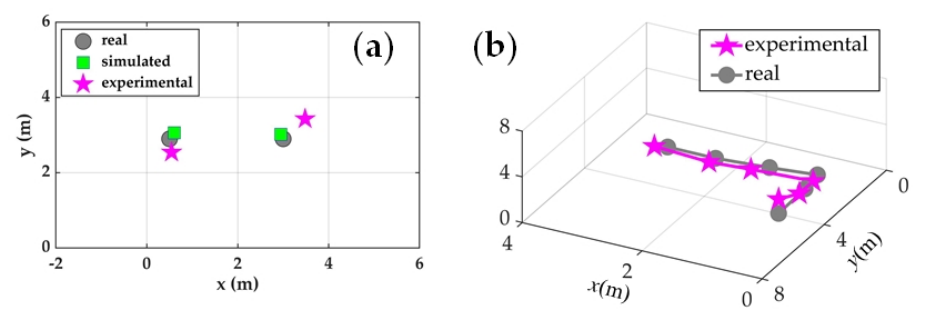
Figure 17. Experimental results. ( a ) 2D localization with two sources; ( b ) 3D localization with a source at different positions. Reproduced with permission from our previous paper [29], published by Optical Society of America, 2019.